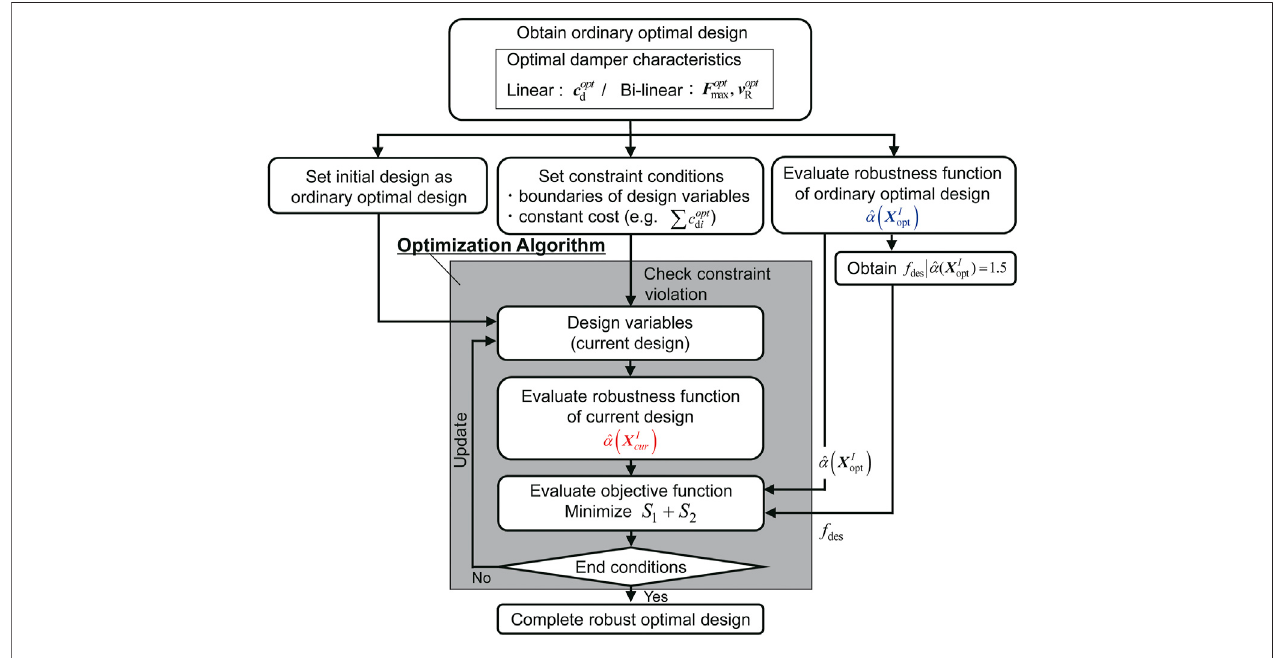
FIGURE 5 | Flowchart for solving proposed robust optimization problem.